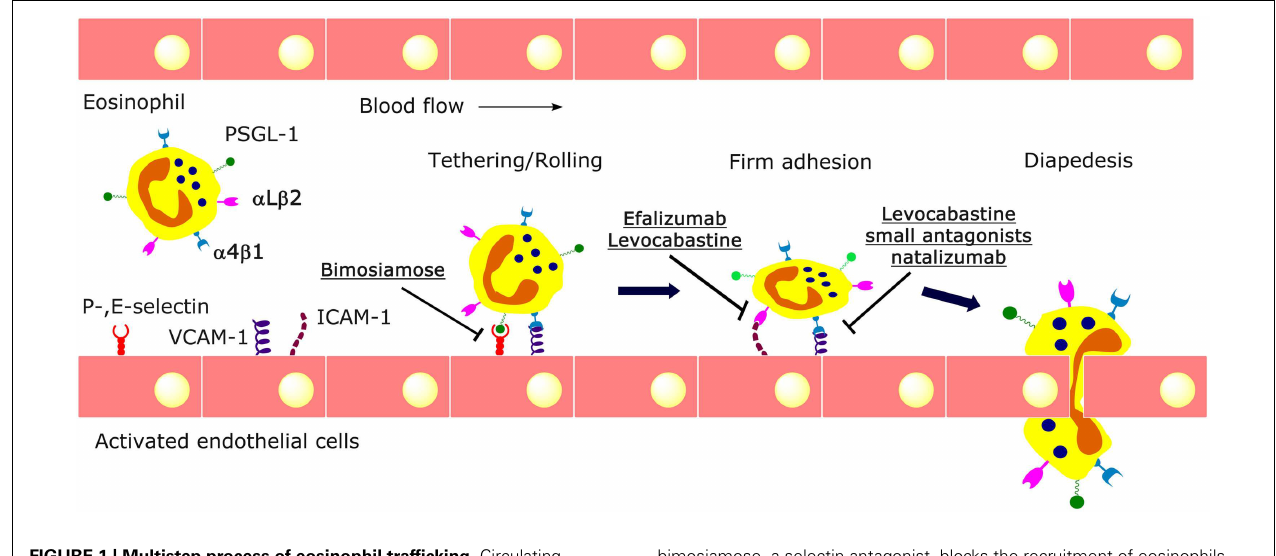
FIGURE 1 | Multistep process of eosinophil trafficking. Circulating leukocytes initially tether and roll on endothelium via selectins and α 4 β 1 integrin, followed by firm adhesion to endothelium via β 1 and β 2 integrins, and subsequent extravasation between endothelial cells. Cell adhesion-based therapeutic strategies specifically target adhesion molecules. For example,